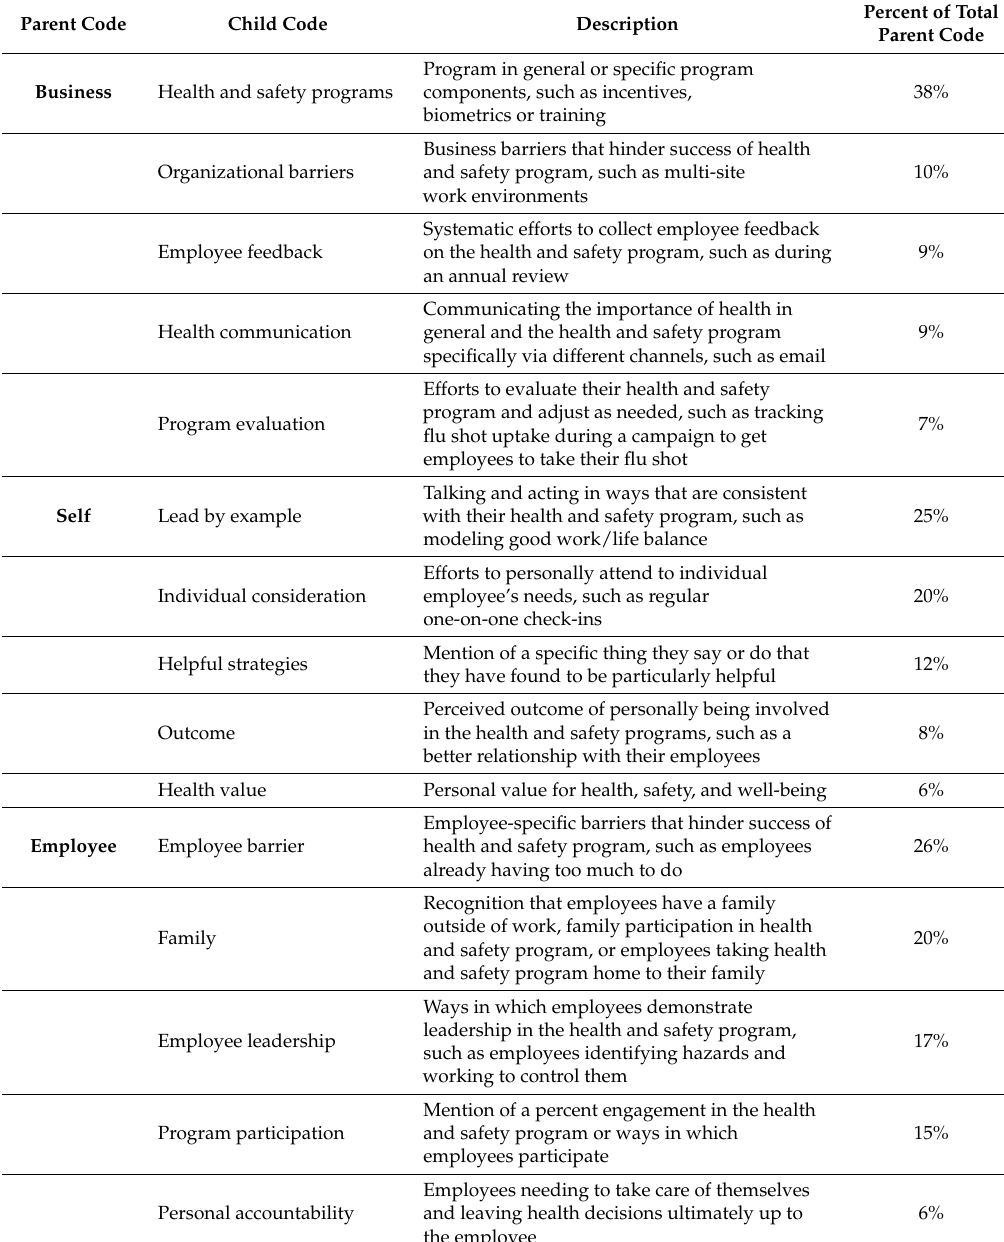
Table 1. Percent of child codes mentioned in leader interviews by parent